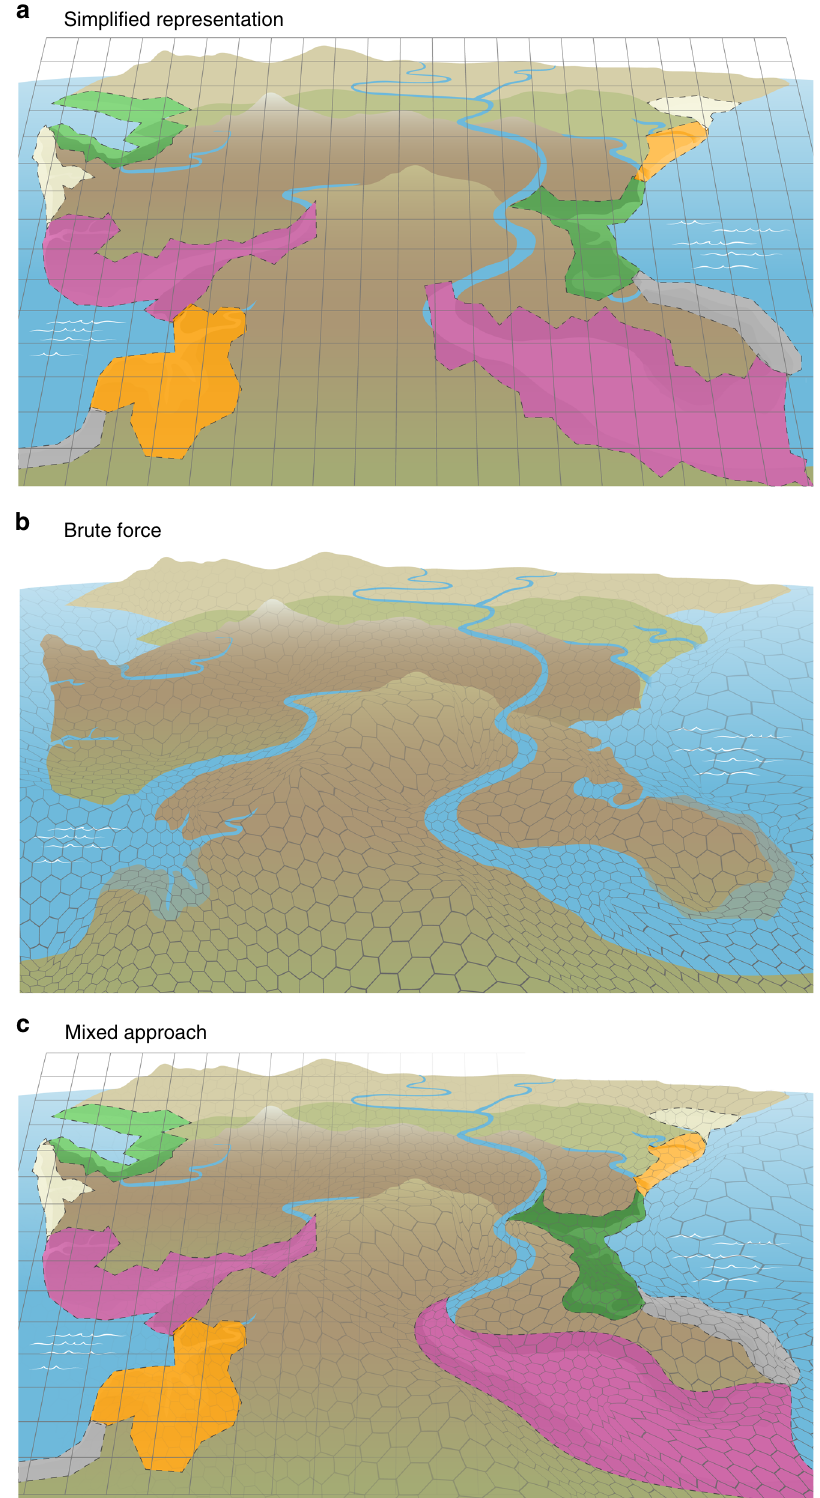
Fig. 5 Representing coastal interfaces in Earth system models. a Perhaps the simplest approach would be to classify coastal interfaces based on a series of functional types for their main features (i.e., different types of tidal rivers, estuaries, intertidal ecosystems, and shoreline ecosystems; Fig. 2). Process parameterizations derived from synthesized data would be applied to the fraction of a pixel occupied by each feature rather than the current state of the art, which assigns some fraction of coastal pixels as land and some fraction as ocean. b The most sophisticated approach would be to couple high- resolution regional coastal interface models with coarser resolution Earth system models using a variable pixel size (i.e., Voronoi mesh). c Perhaps the most feasible and robust approach would be a combination of the two, whereby existing or strategically developed high-resolution models are coupled, and classi fi cations of functional types are applied to systems where data required for high-resolution models are not